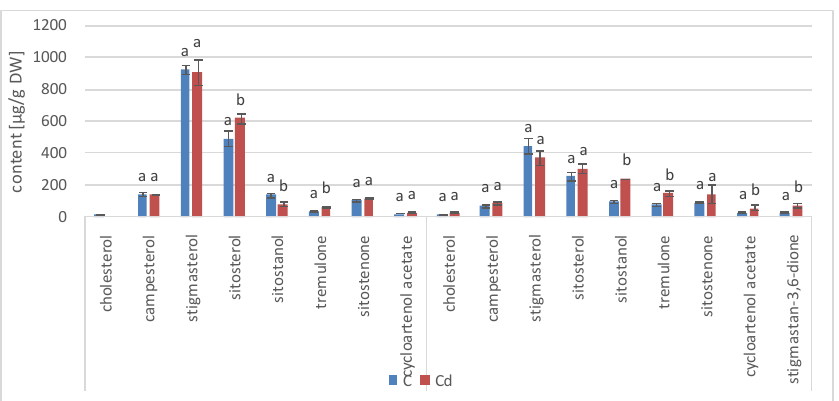
Figure 17. The content of free sterols in roots of control and Cd- treated C. officinalis plants after 7 and 14 days of cultivation. Bars which do not share a common letter are significantly different ( p < 0.05).